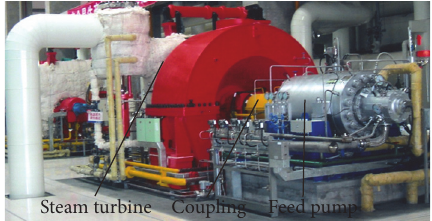
Figure 4: Photo of the steam turbine feed pump.